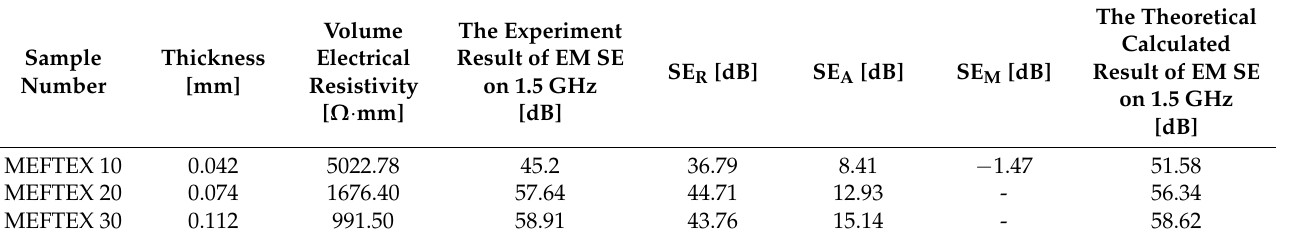
Table 3. Volume electrical resistivity and EMSE, SE R , SE A , SE M at 1.5